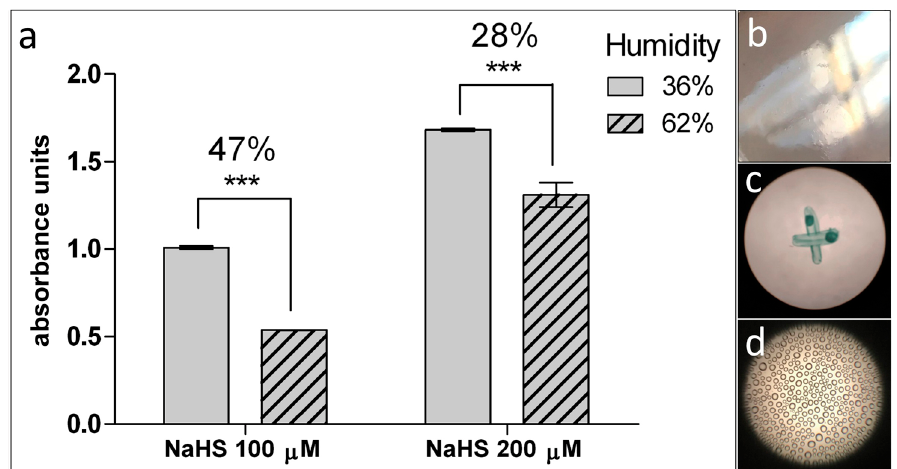
Figure 5. Effect of microenvironment humidity on the H 2 S recovery in the agar trap assay. The detection of H 2 S release is performed with agar trap method. ( a ) H 2 S released from 2 mL 100 and 200 μ M NaHS aqueous solution, in 1 h at 37 °C by incubating in 36% or 62% humidified atmosphere. Percentage difference between samples incubated under various microenvironment conditions are indicated above each histogram. Examples of: ( b ) Photograph of polymerized dry agar gel before experiment; ( c ) microphotograph of agar gel in the sample incubated at 36% of humidity; and ( d ) microphotograph of agar gel with microdrops in a sample incubated at 62% of humidity. p value versus sample incubated at 36% of humidity: *** p < 0.001 (according to the Student’s two-tailed t-test).